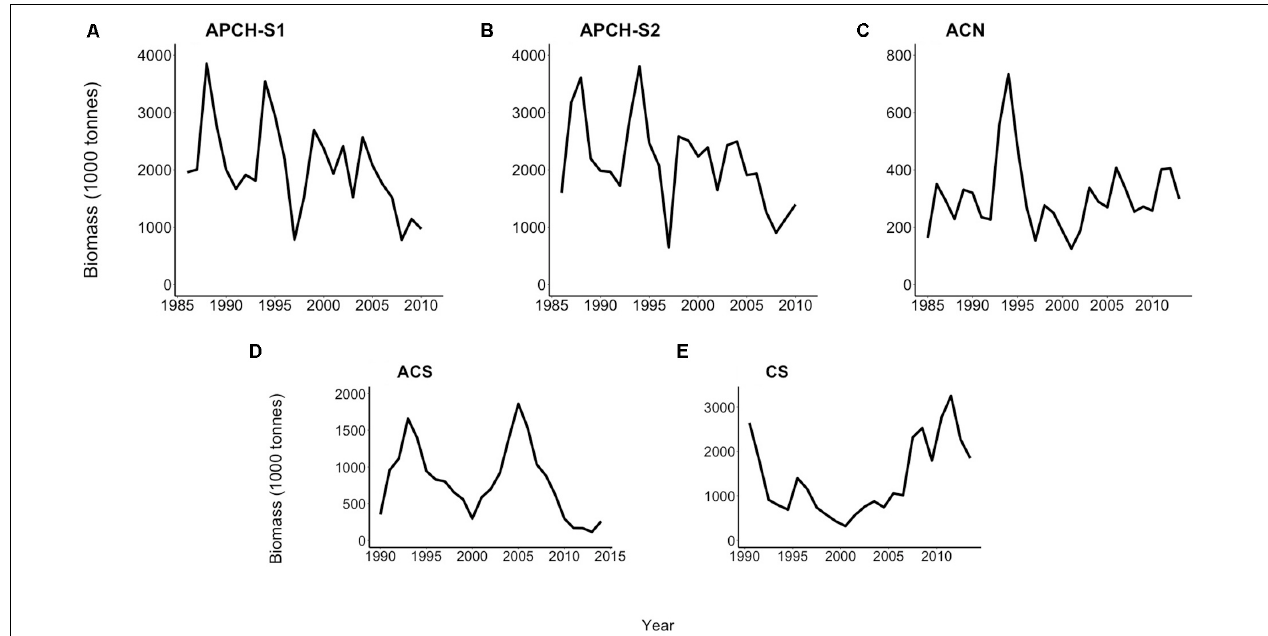
FIGURE 2 | Biomass (tonnes) time series of the Chilean small pelagic fish populations. Anchovy population of southern Peru and northern Chile (APCH) from 1986 to 2010. (A) APCH-S1, biomass semester January–June and (B) APCH-S2, anchovy biomass semester July to December. (C) Anchovy population off central-northern Chile (ACN) from 1985 to 2013. (D) The anchovy population (ACS) and (E) common sardine (CS) population off central-southern Chile includes estimates from 1990 to